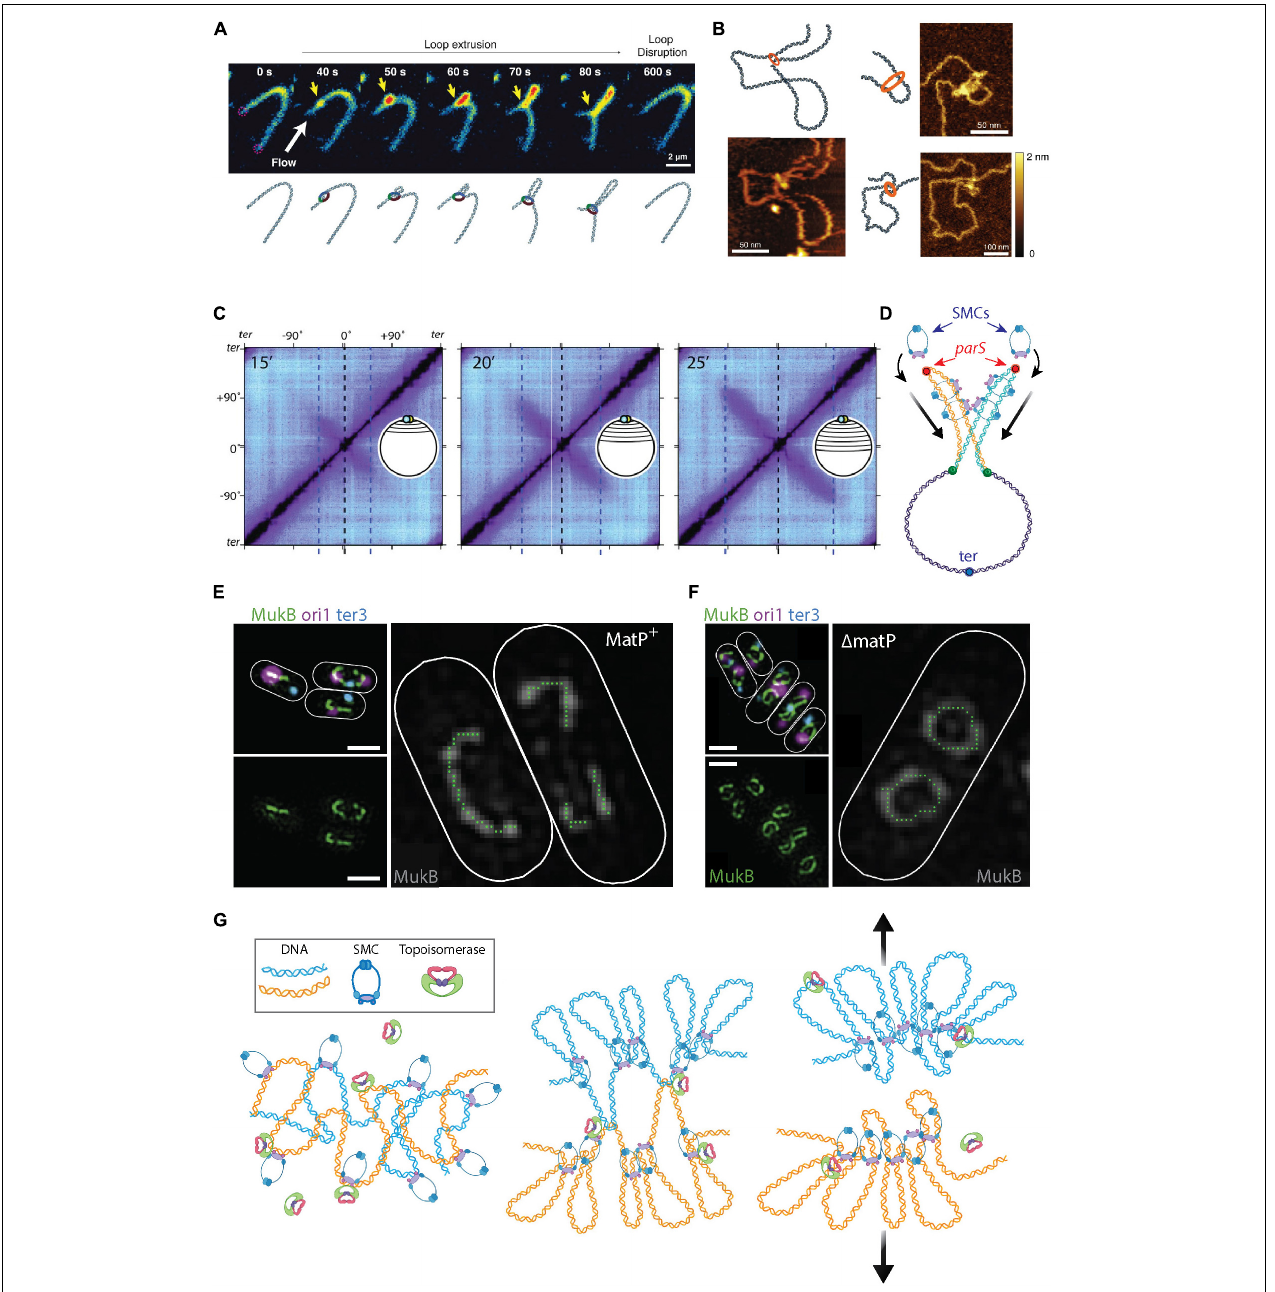
FIGURE 3 | The roles of SMCs in organizing and segregating the bacterial chromosomes. (A) Time-lapse images of a single SMC complex (yellow arrow) that extrudes a DNA loop in vitro . From Ganji et al. (2018). (B) Atomic force microscopy images of a single SMC complex bound to the stem of a DNA loop of varying sizes. From Ryu et al. (2020). (C) Hi-C contact maps show the progressive juxtaposition of chromosome arms as the downward-oriented diagonal lines that increase in size over time. From Wang et al. (2017). (D) Schematic representation of SMC molecules loading onto the parS sites (red dots) at newly replicated sister DNA (orange and blue strands) from the mother (purple strand). Upon loading, the SMC complexes slide over the DNA toward the terminus of replication (blue focus), juxtaposing the chromosome arms of the two sister chromosomes. (E) Fluorescent microscopy images of the MukB SMC (green) structures in Escherichia coli cells. The smaller images on the left show an overlay of MukB with the origin (magenta) and terminus-of-replication (blue) sites. The large image shows a trace of the MukB signal, which visualizes the horse-shoe-shaped half ring, that is discontinued at ter by the presence of MatP. Scale bars 1 µ m. From Mäkelä and Sherratt (2020). (F) Same as panel (E) but for cells where MatP was deleted. Here, the horse-shoe shapes are closed into a fully circular structure. From Mäkelä and Sherratt (2020). (G) Left Sketch of two entangled sister chromosomes directly after replication. Middle Chromosome compaction by the action of SMCs. DNA loop extrusion by SMCs leads to a bottle brush chromosome structure, but full segregation between sister chromosomes is impeded by topological links between the sister chromosomes. Right Concatenations between the chromosome sister are resolved by topoisomerase action and entropic repulsion completes the segregation.